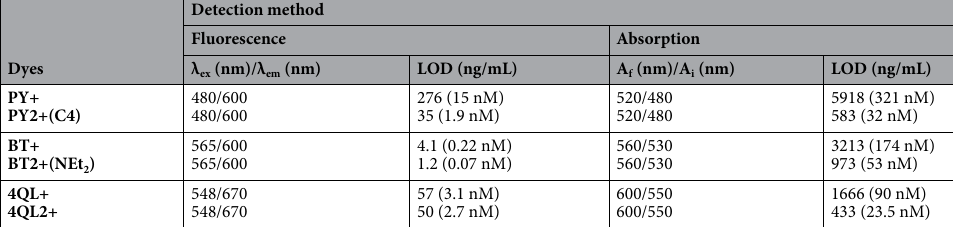
(Fig. S27). The dye 4QL2+ (− 9.5 kcal/mol) had a slightly better binding energy than BT2+(NEt 2 ) (− 9.0 kcal/ mol) and PY2+(C4) (− 8.4 kcal/mol) possibly due to the favorable π–π stacking of quinoline to the nucleobases.